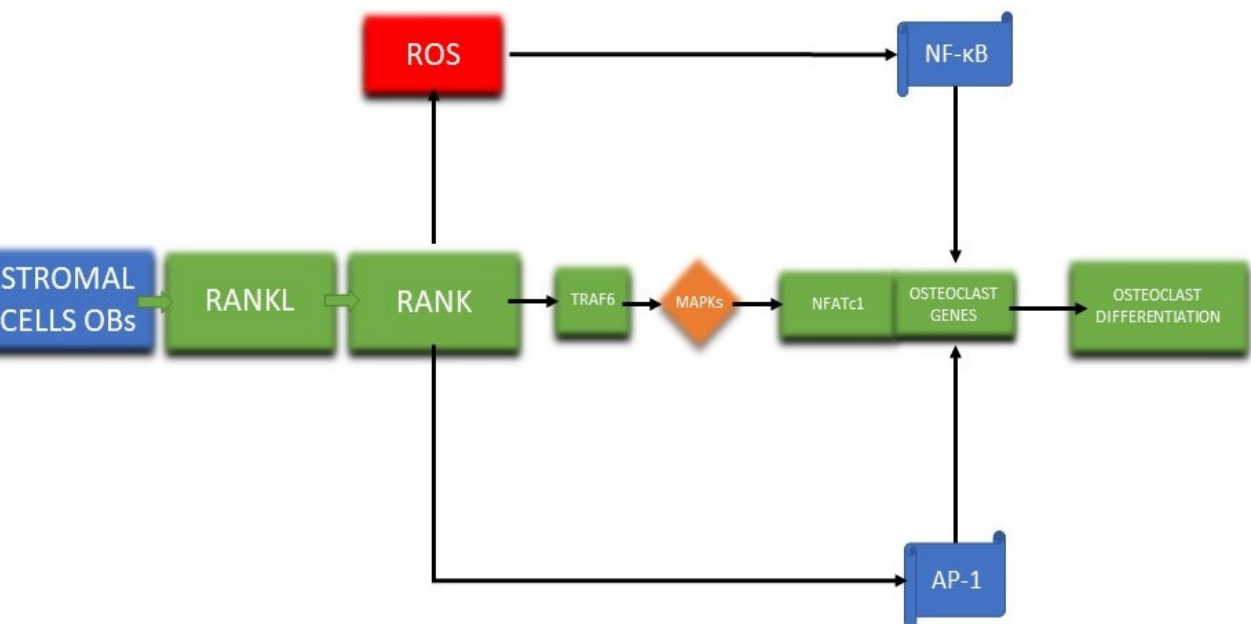
Figure 4. The signaling pathway for osteoclasts differentiation (adapted from an open-access source) [148]. Reactive oxygen species (ROS) are molecules and free radicals (e.g., superoxide an- ion, hydrogen peroxide, hydroxyl radical) mainly resulting as byproducts of leaked elec- trons from the mitochondrial electron transport chain during aerobic respiration